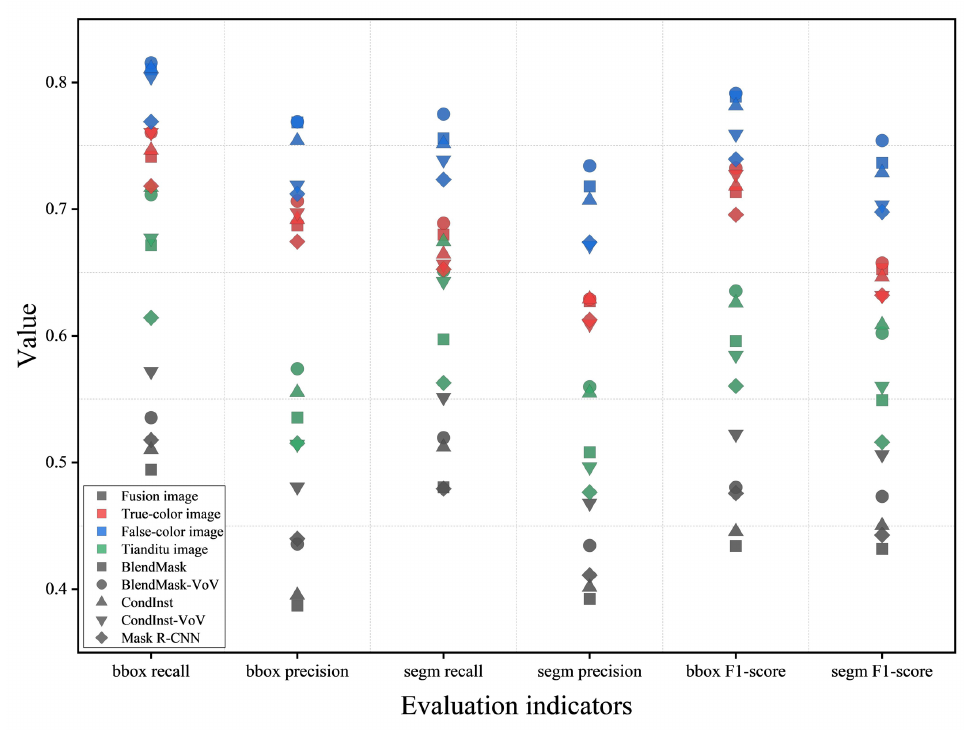
Figure 13. The evaluation indicators of inference on different types of images in the KOMMA dataset by five